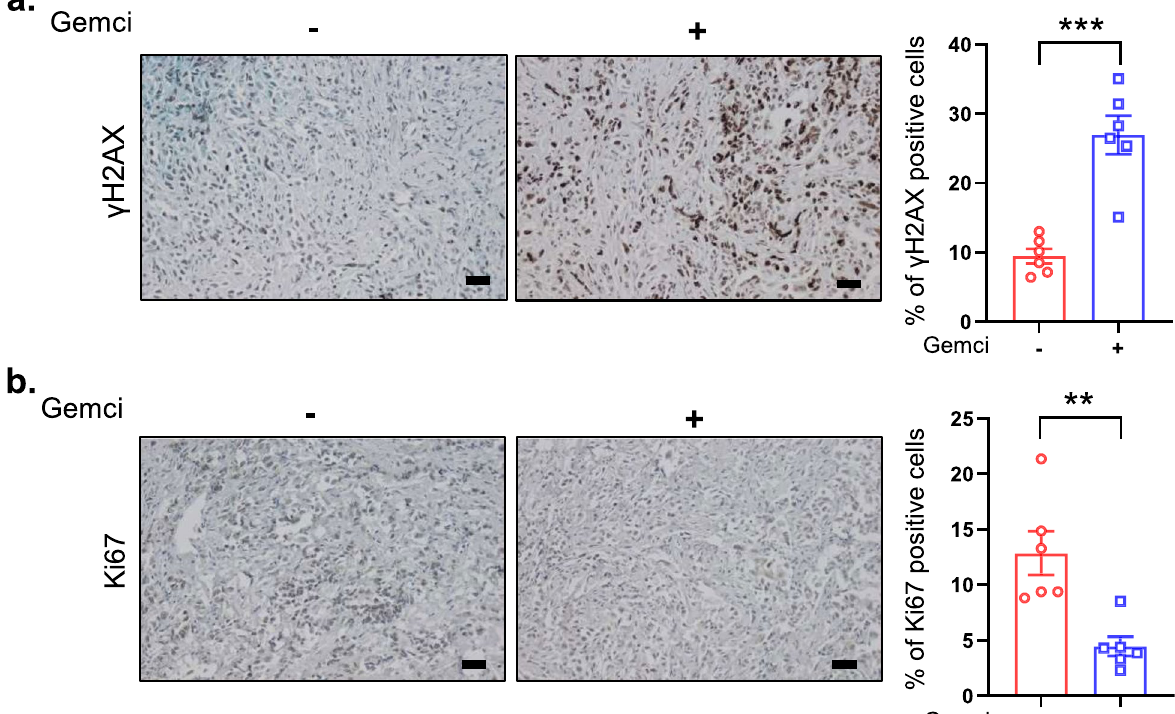
Fig. 3 Gemcitabine induces some senescence feature in xenografted tumors. a‑b , Panc1 cells were injected subcutaneously into immunodeficient mice. When tumors reached an average size of 70‑100 mm 3 , mice were treated 3 times, every two days, with gemcitabine ( n One week after the first treatment mice were euthanized, tumors prepared and immunohistochemistry against γH2AX ( a ) or Ki67 ( b ) performed. Percentage of positive cells was calculated (scale bar